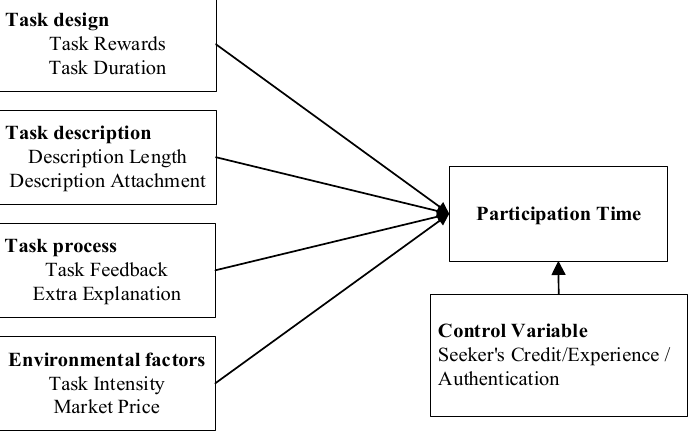
Figure 1. Participation Time Research Model.